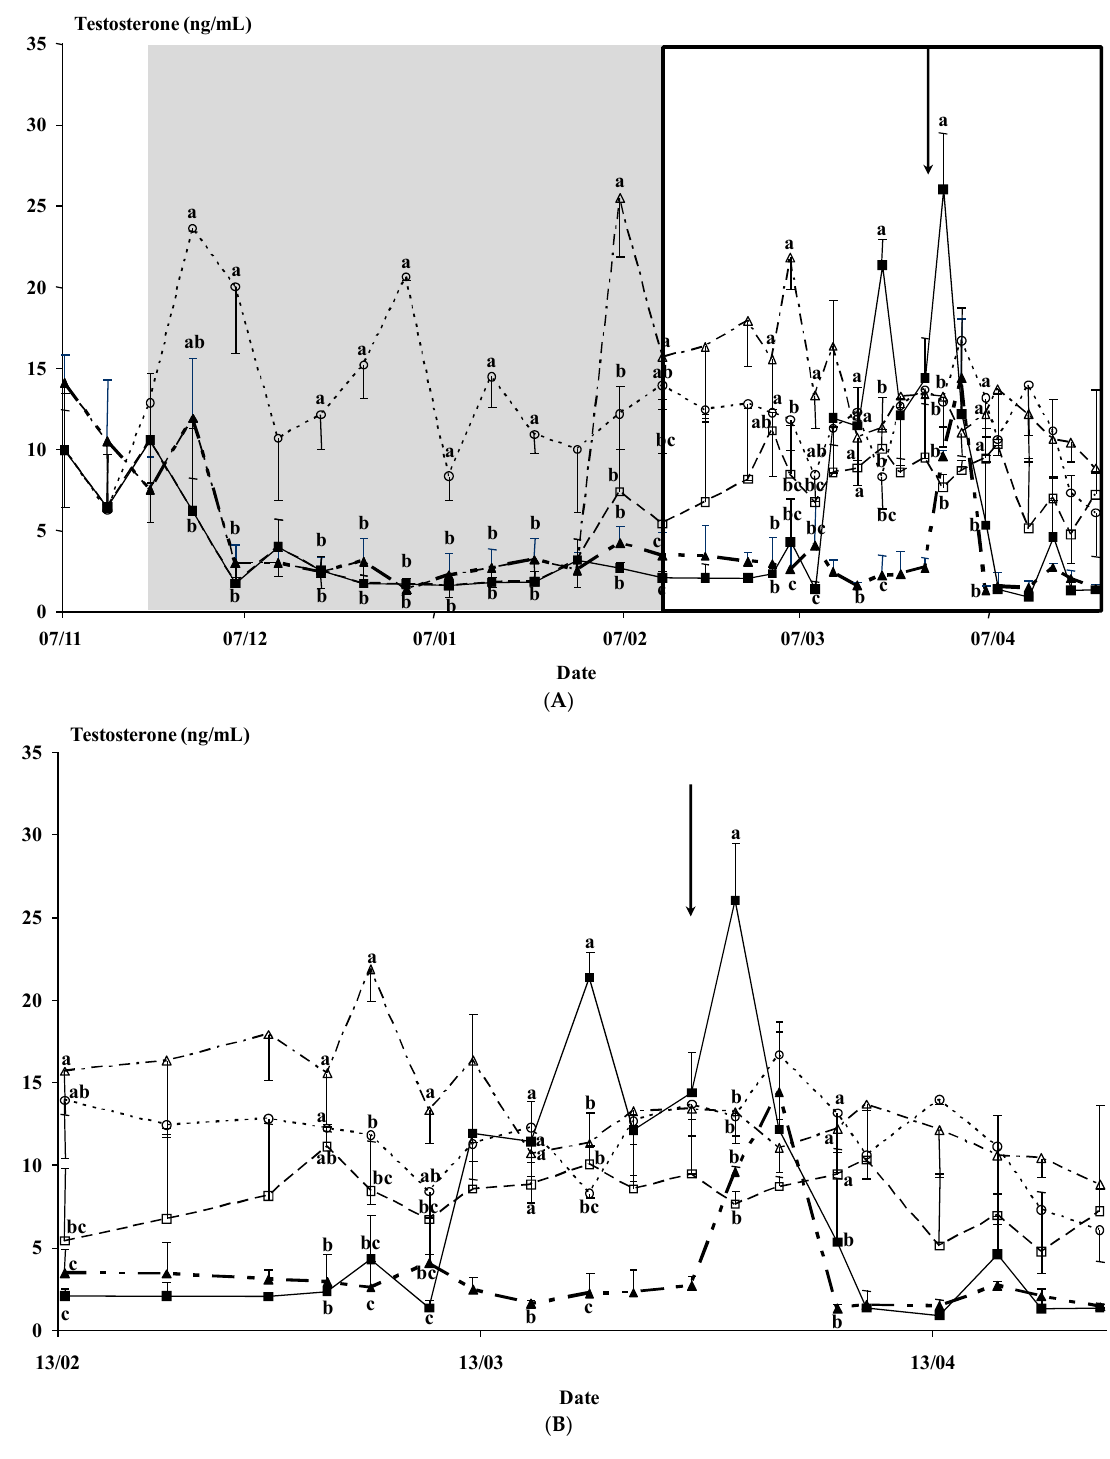
Figure 4. ( A ). (Experiment 2). Plasma testosterone concentrations (ng/mL) of males were used to induce the male effect. The groups were: males submitted to a photoperiod treatment, i.e., long days for three months between November and February ( , n = 2, Photo); males submitted to the same photoperiod treatment and given a GnRH agonist at the onset of the photoperiod treatment ( , n = 2, Photo-Ago Long); males submitted to the same photoperiod treatment and given a GnRH agonist at the end of the photoperiod treatment ( , n = 2, Photo-Ago Short); males subjected to the natural photoperiod and a GnRH agonist at the same time as the Photo-Ago Short ( , n = 2, Nat- ural-Ago Short) and males subjected to the natural photoperiod ( , n = 2, Natural). The shaded area indicates the photoperiod treatment duration. The inset figure in the box indicates that it will be magnified for better viewing ( B ). The arrow indicates the moment of the introduction of the bucks. Different letters in the same day differ significantly between male groups, p < 0.05. ( B ) (Ex- periment 2). This figure is a magnification of the box period presented in ( A ), between the end of the photoperiod treatment and the end of the experiment. The description of the groups is the same as in ( A ). Plasma testosterone concentrations (ng/mL) of males were used to induce the male effect. The groups were: males submitted to a photoperiod treatment, i.e., long days for three months between November and February ( , n = 2, Photo); males submitted to the same photoperiod treatment and given a GnRH agonist at the onset of the photoperiod treatment ( , n = 2, Photo-Ago Long); males submitted to the same photoperiod treatment and given a GnRH agonist at the end of the photoperiod treatment ( , n = 2, Photo-Ago Short); males subjected to the natural photoperiod and a GnRH agonist at the same time as the Photo-Ago Short ( , n = 2, Natural-Ago Short) and males subjected to the natural photoperiod ( , n = 2, Natural). The arrow indicates the moment of the introduction of the bucks. Different letters in the same day differ significantly between male groups, p < 0.05.